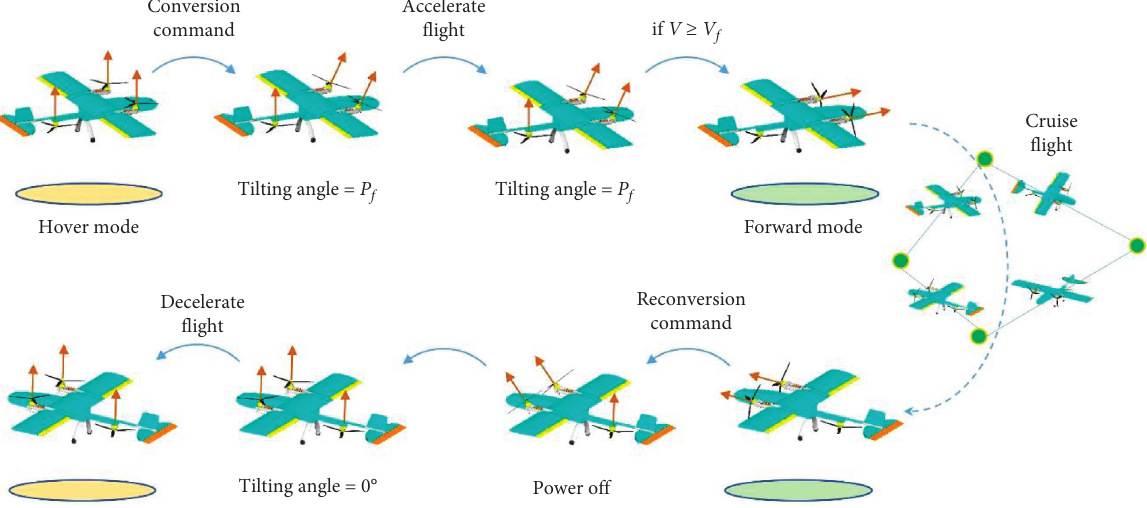
Figure 8: Mode transition strategy.